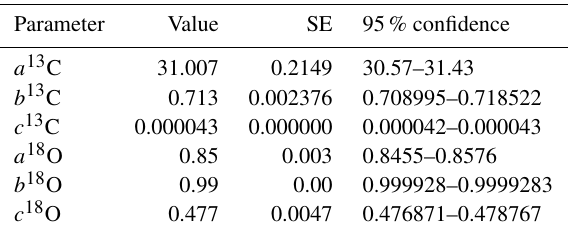
Table 3. Parameter values for correction factor model fit for Diff- δ 13 C and Diff- δ 18